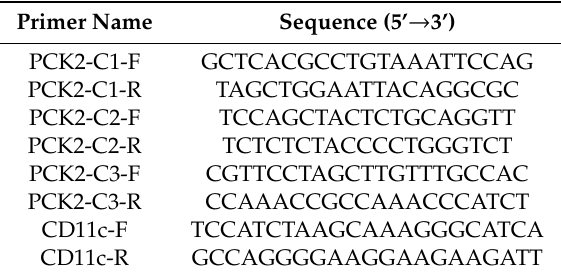
Table 2. ChIP-PCR / qPCR